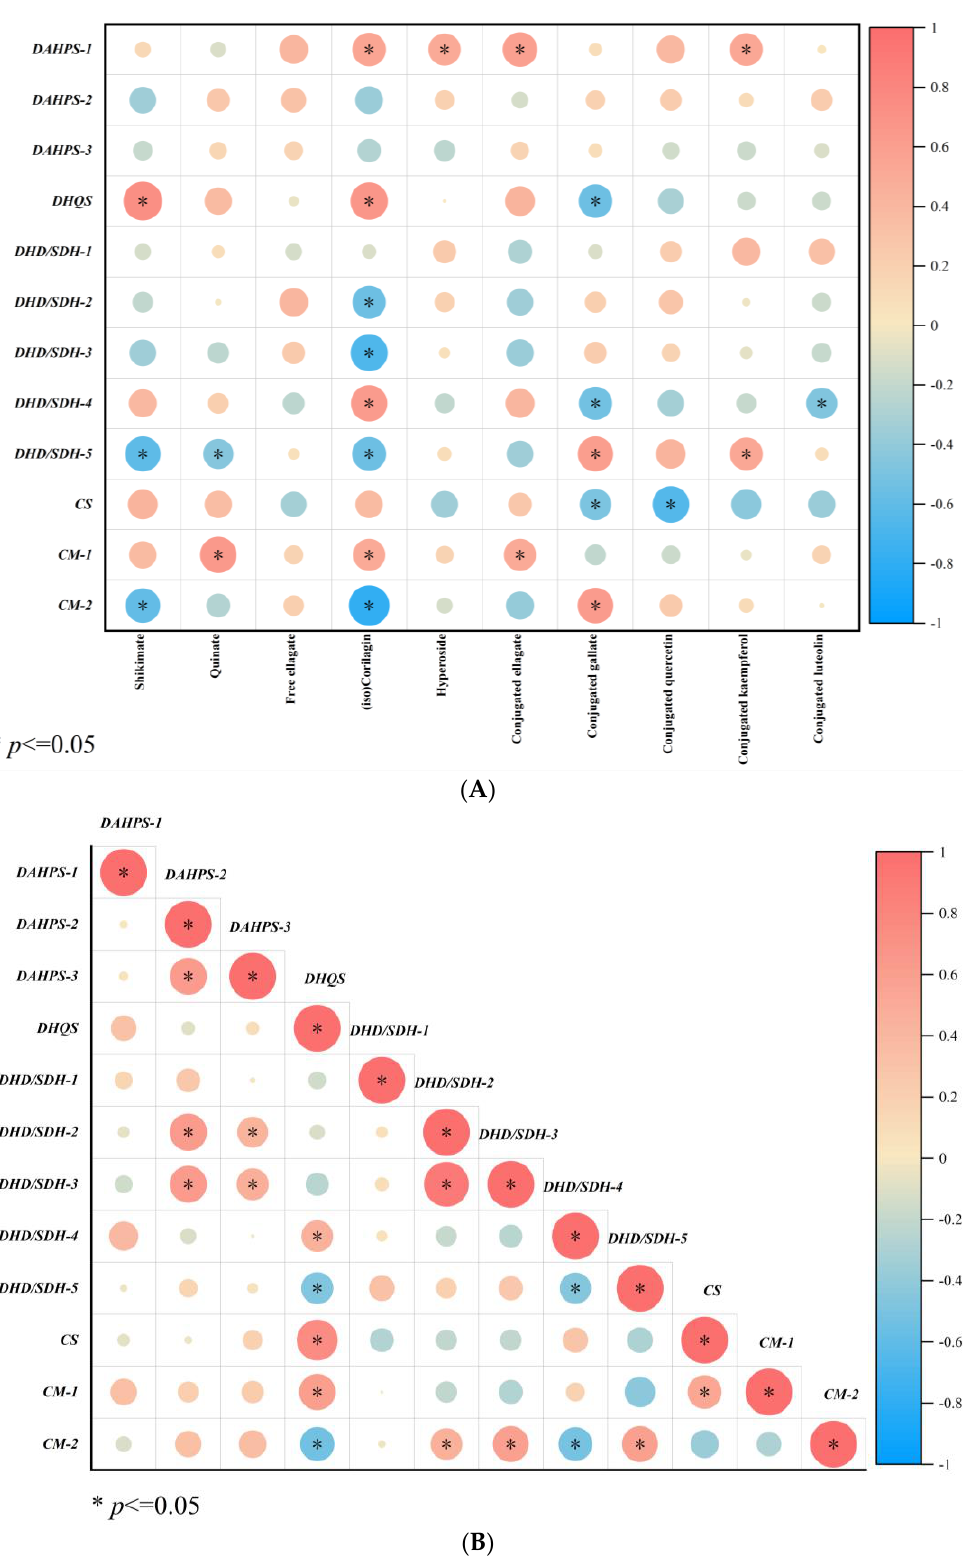
Figure 8. Correlation analysis heat map: * denotes significant differences at 0.05. ( A ) Correlation analysis between shikimate-metabolism-related genes and components and ( B ) correlation analysis of shikimate-metabolism-related